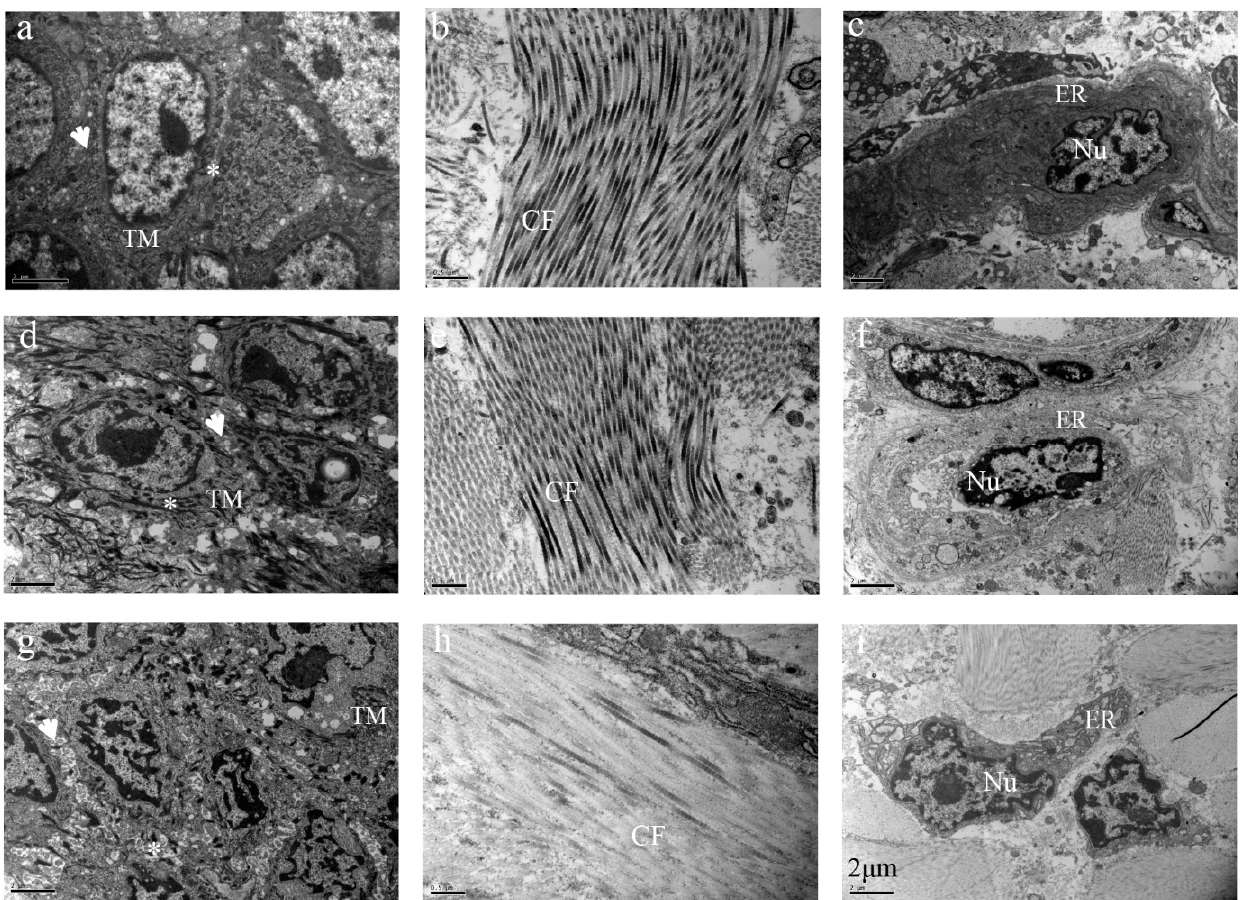
Figure 5. Ultrastructural evaluation of ear tissues cryopreserved for 6 months. ( a – c ), fresh tissue; ( d – f ) cryopreserved tissue; ( g – i ) frozen tissue without protection. Nu: Nuclear; CF: Collagen fi bers ER: Endoplasmic reticulum; TM: Tension micro- fi laments; *: Desmosomes; ↑ : intercellular space.